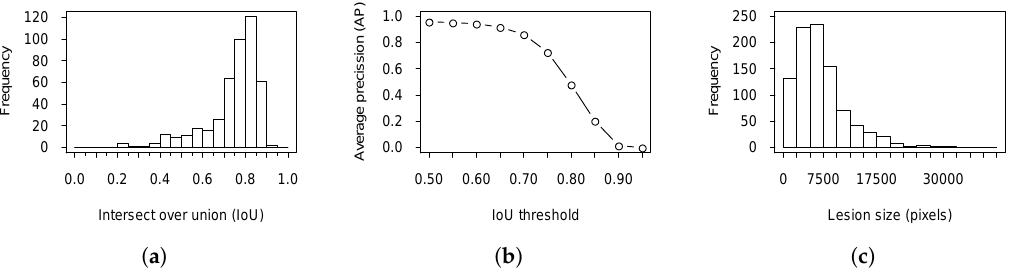
Figure 1. Metrics used to assess the accuracy of a Mask R-CNN model trained to detect northern leaf blight (NLB) lesions. ( a ) Distribution of intersection over union (IOU) values between predicted masks and ground truths. ( b ) Average precision at IOU thresholds of 0.50–0.95. ( c ) Size of lesions (pixels) predicted by the trained Mask R-CNN model.